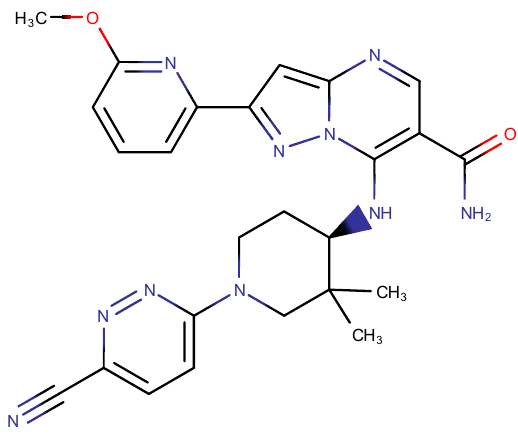
Figure 2. Chemical structure of Figure 2 . Chemical structure of CPL409116.